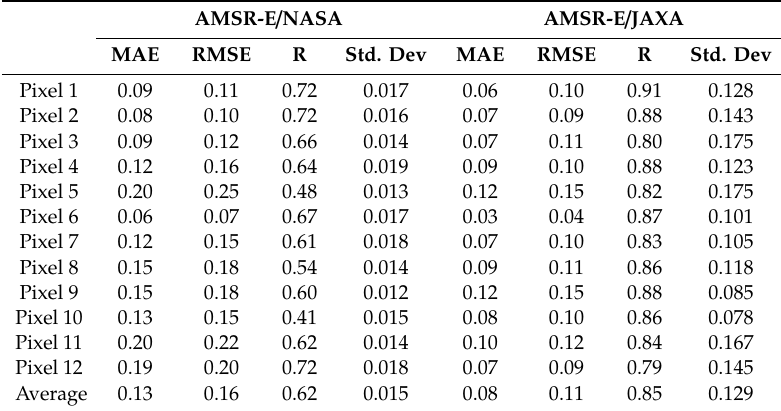
Table 2. Calculated MAE , RMSE , and R of SM data in the Naqu area against in-situ SM measurements in 2011; st. dev are the standard deviation of each SM data product for each pixel, respectively.